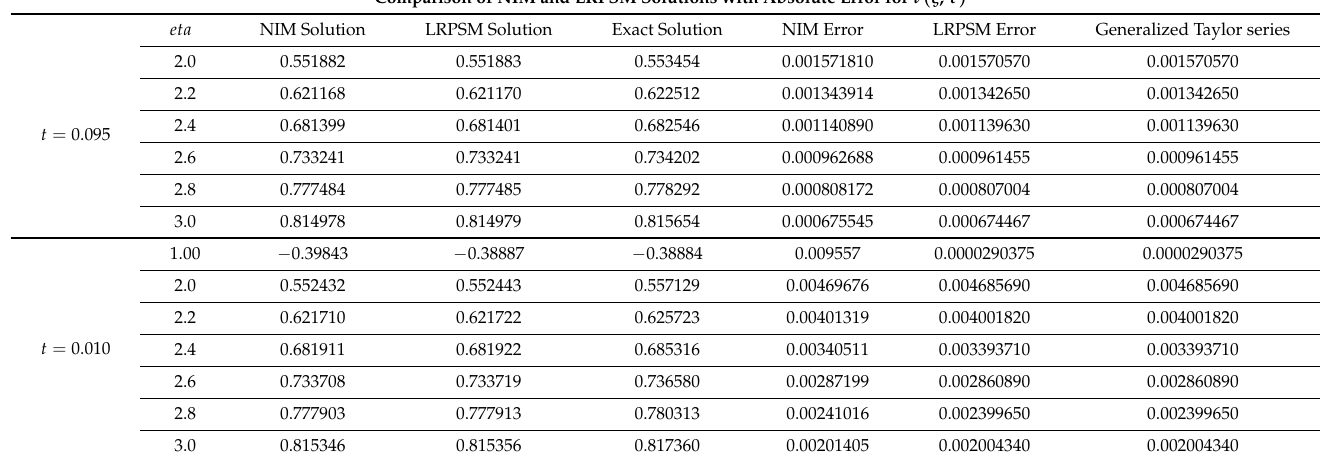
Table 2. The numerical results of ν ( ς , τ )